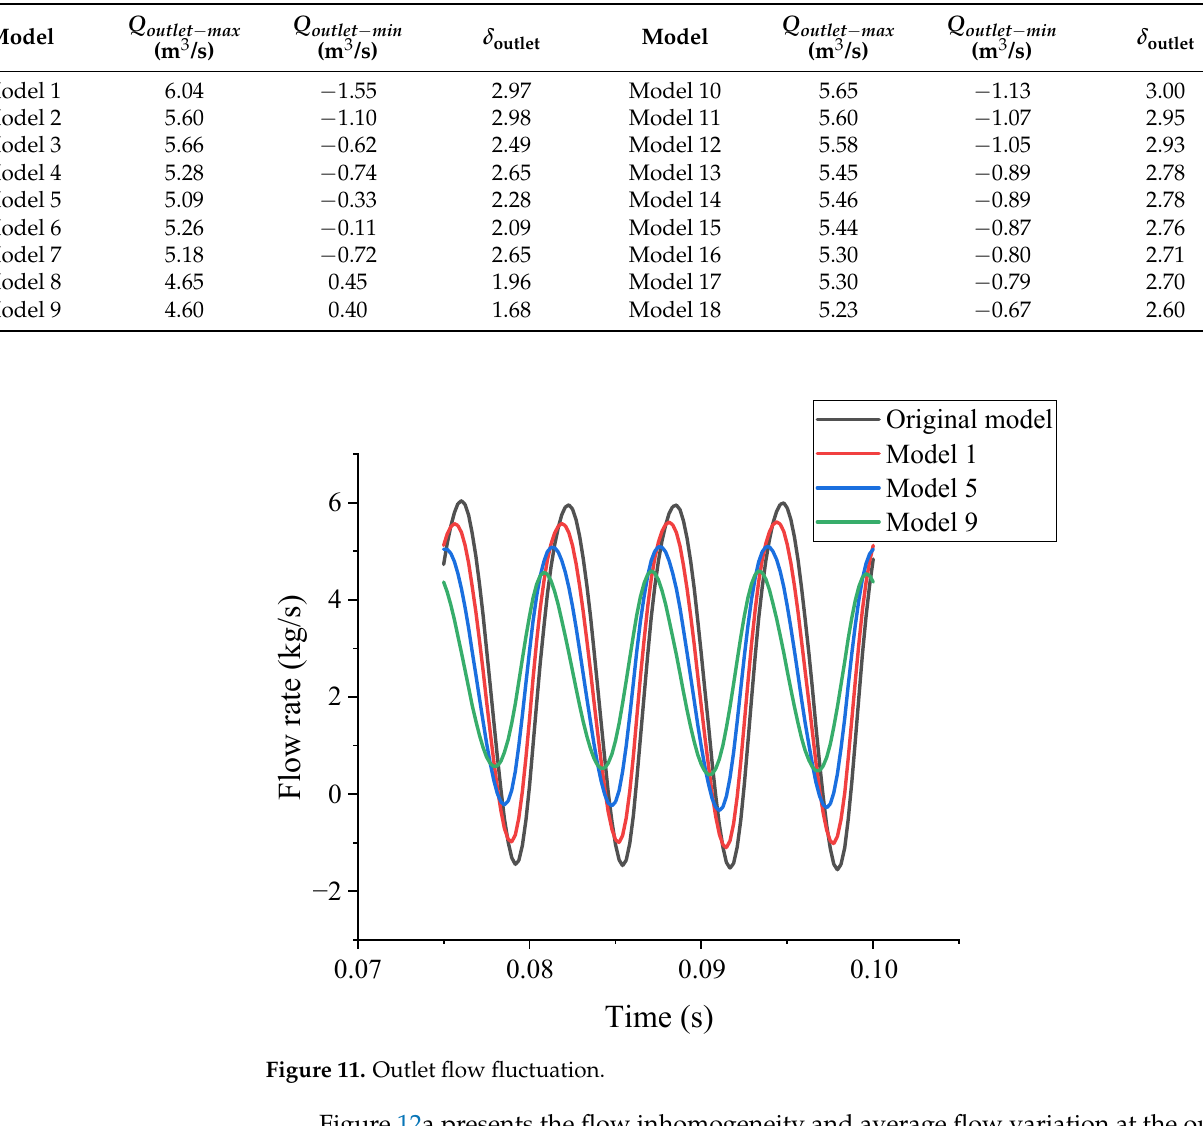
Table 4. Date of the outlet exhaust.